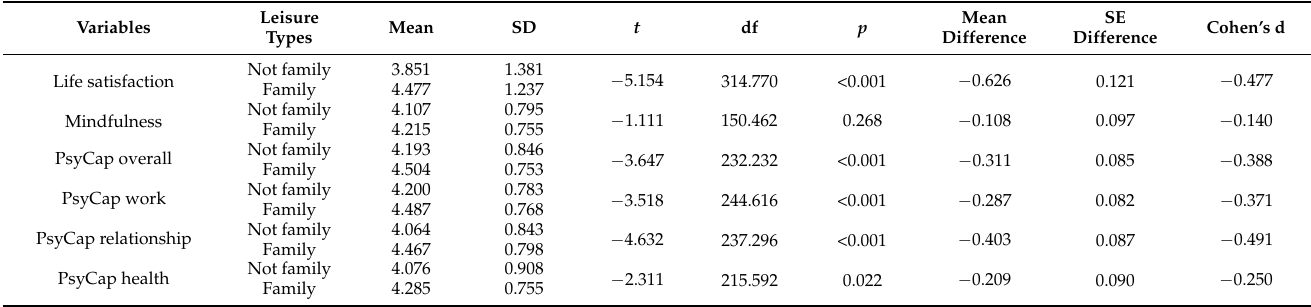
Table 11. Comparison (Welch’s t -test) of life satisfaction, mindfulness, and psychological capital in groups of respondents who prefer and do not prefer spending leisure time with